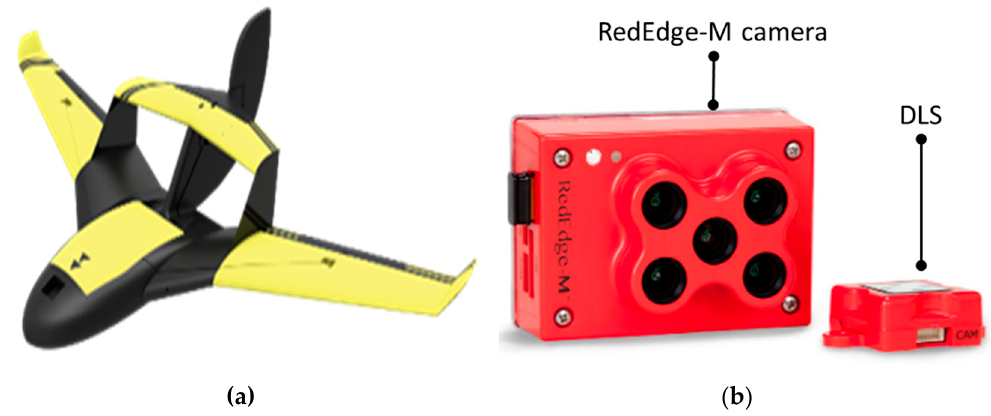
Figure 2. ( a ) The KD-2 fixed-wing unmanned aerial vehicle (UAV) and ( b ) the multispectral camera with irradiance sensor.